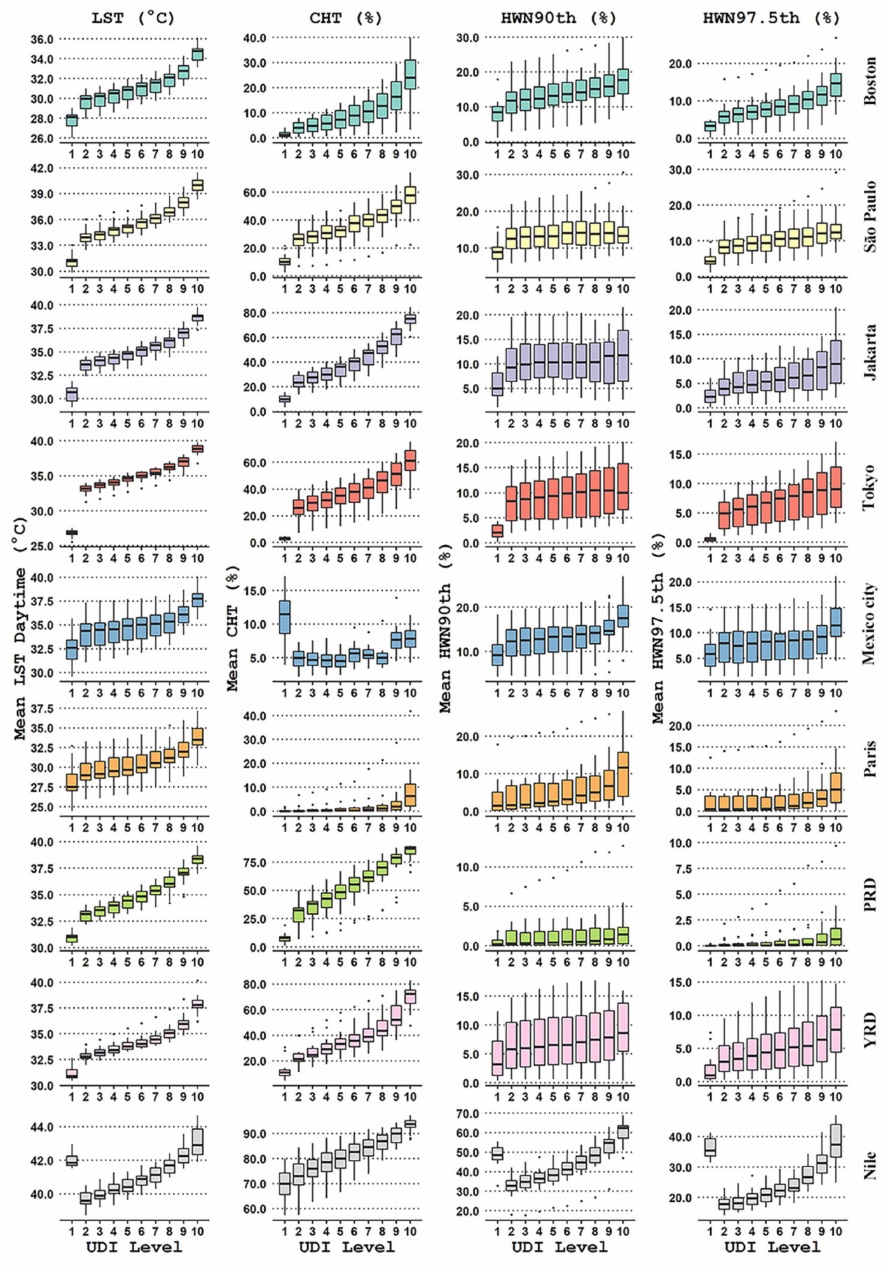
Figure 4. Daytime of Mean LST, CHT, HWN90th, and HWN97.5th within each UDI level during the study period. Each class is plotted from 18 data points which represent the areal mean LST of the class in different mega-regions from 2003–2020,